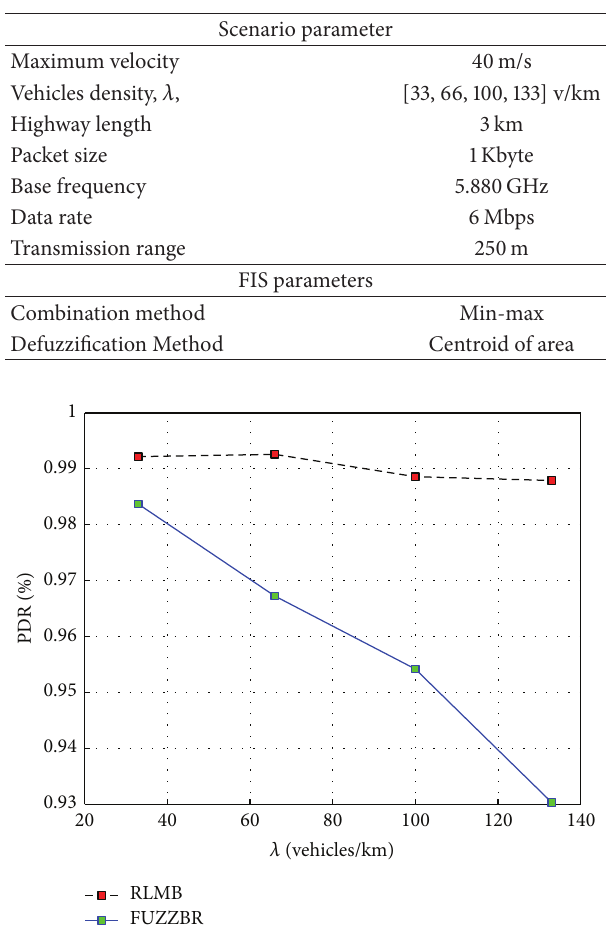
Figure 8: Packet delivery ratio (PDR) obtained with RLMB (0.25 hps) and FUZZBR (1 hps) when increasing thevehicles density, 𝜆 .